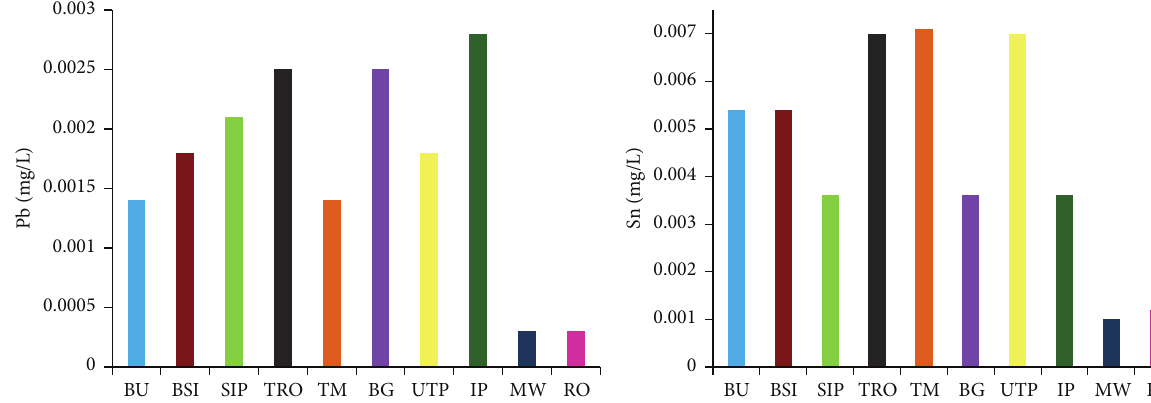
Figure 3: Heavy metals analysis of drinking water samples in Perak state, Malaysia.